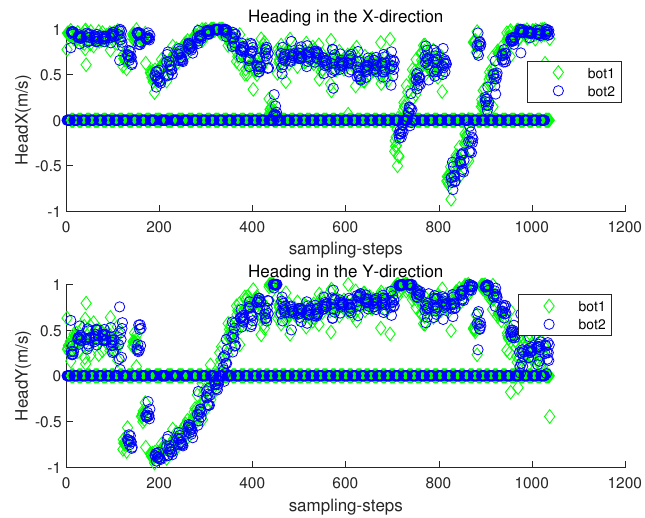
Figure 12. Scenario 2. head x and head y with respect to